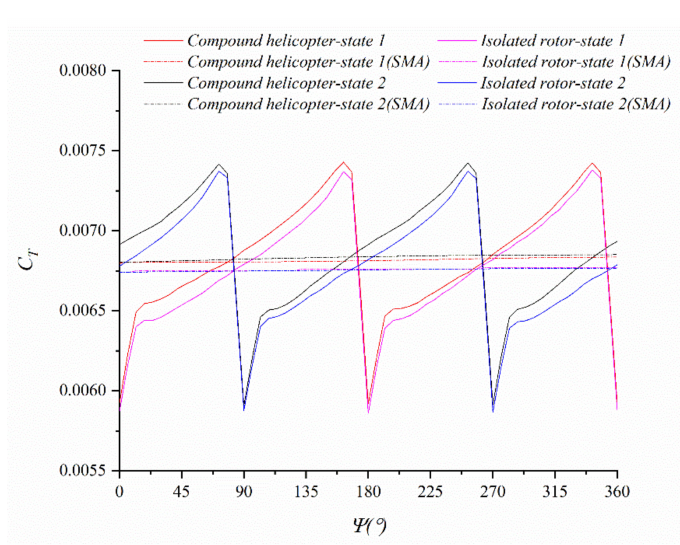
Figure 24. The compound coaxial helicopter upper rotor C T in hover.